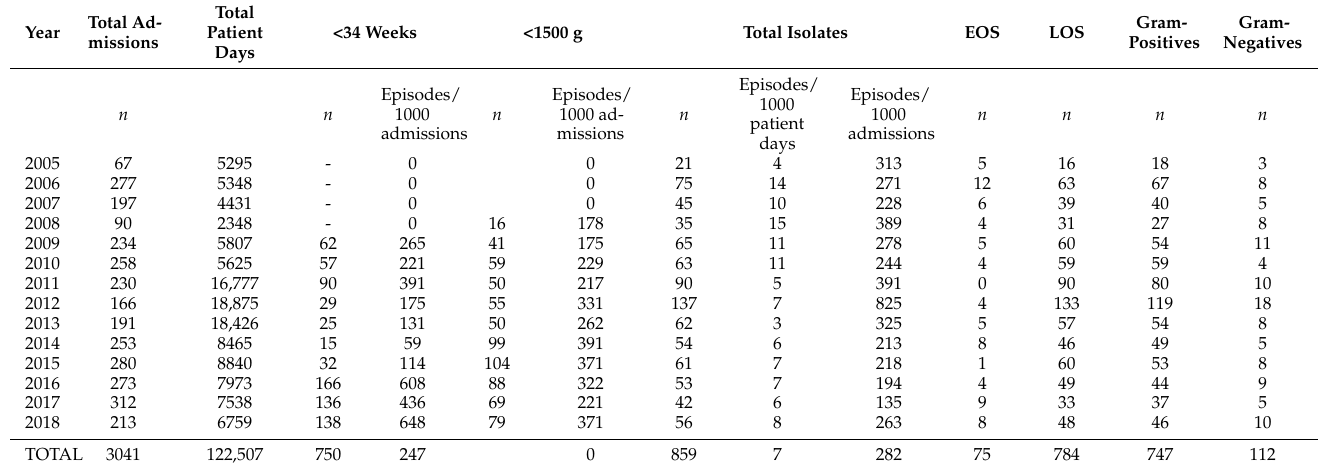
Table 1. Summary of epidemiological